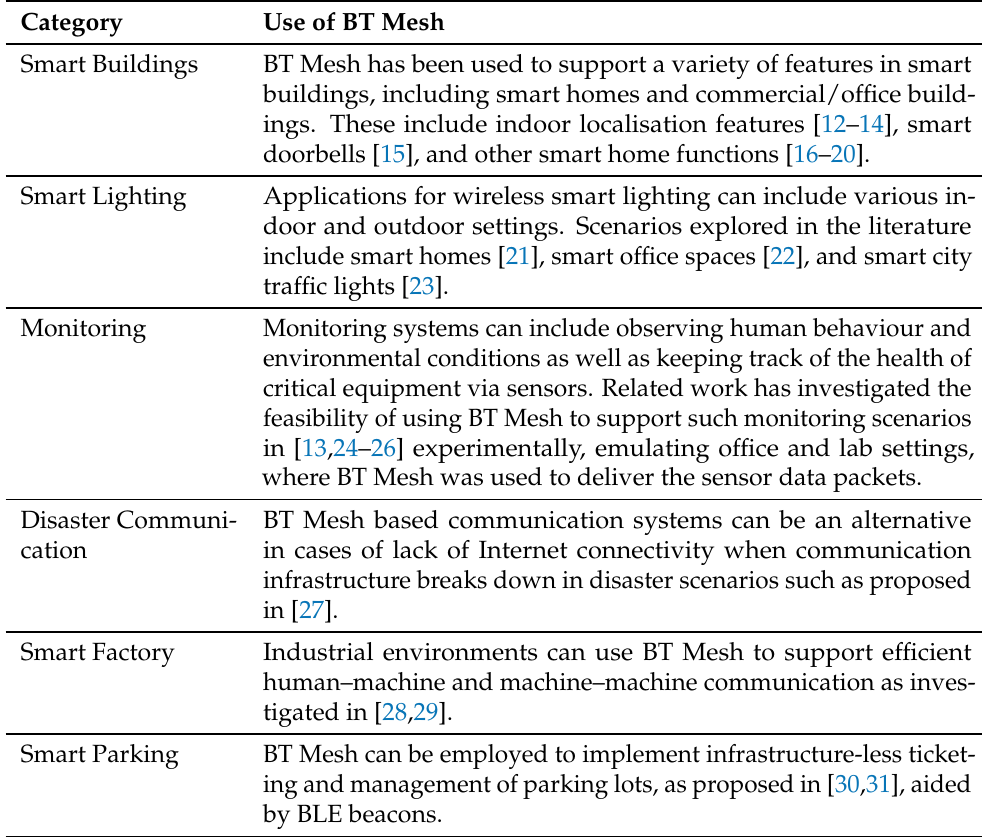
Table 1. Classification of IoT applications using Bluetooth Mesh in related